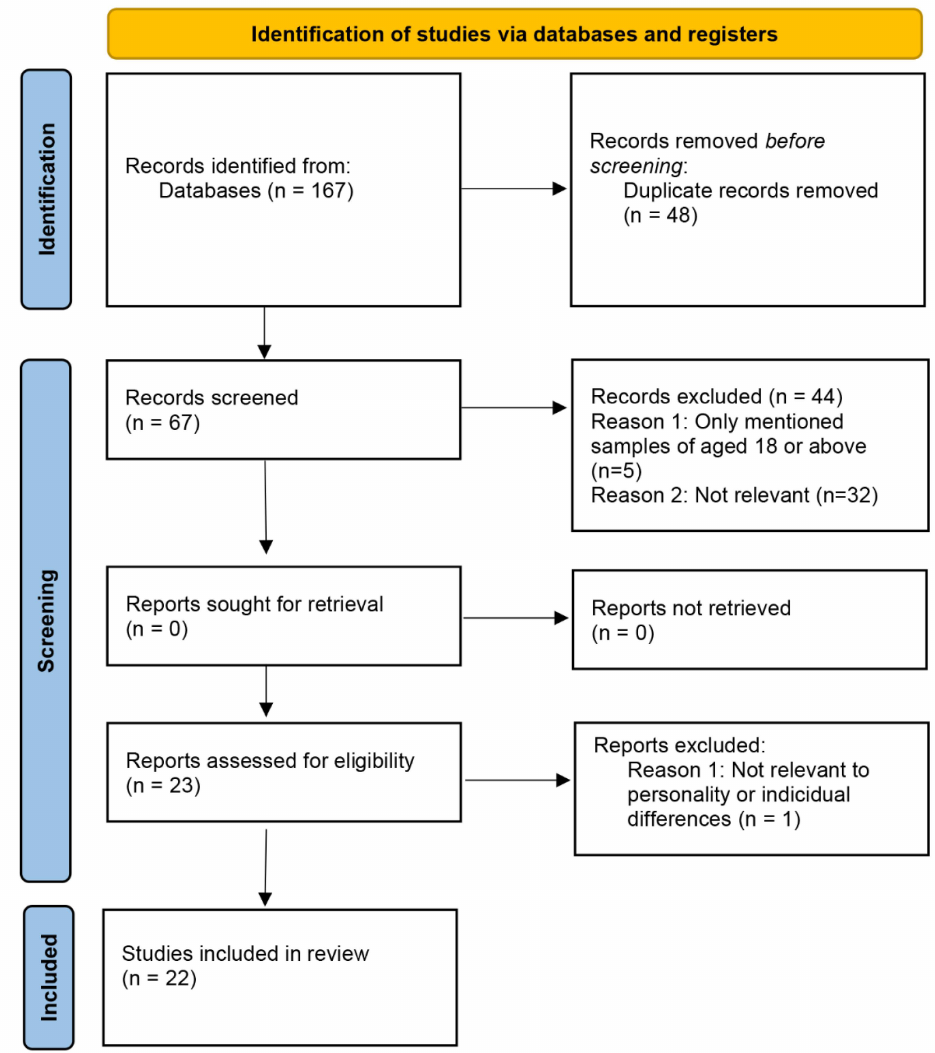
Figure 1. Flowchart of the literature search